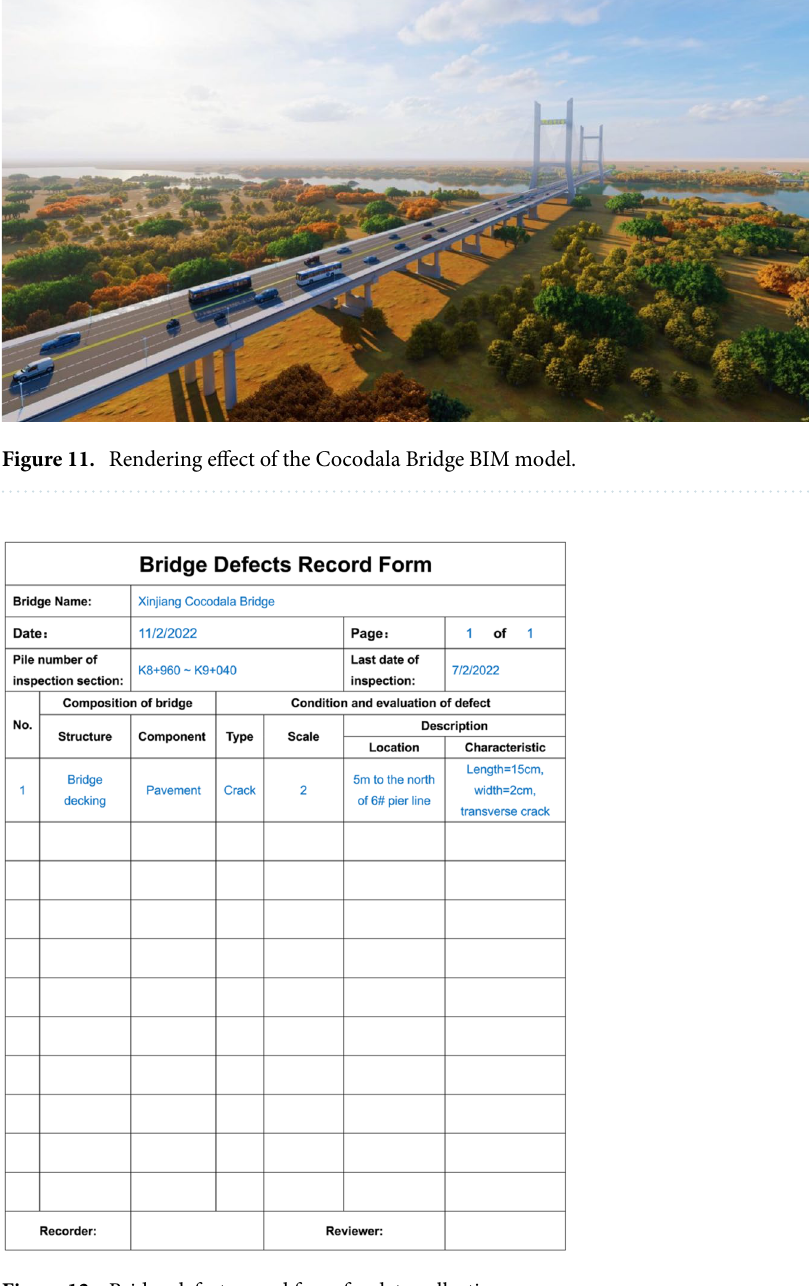
Figure 12. Bridge defect record form for data